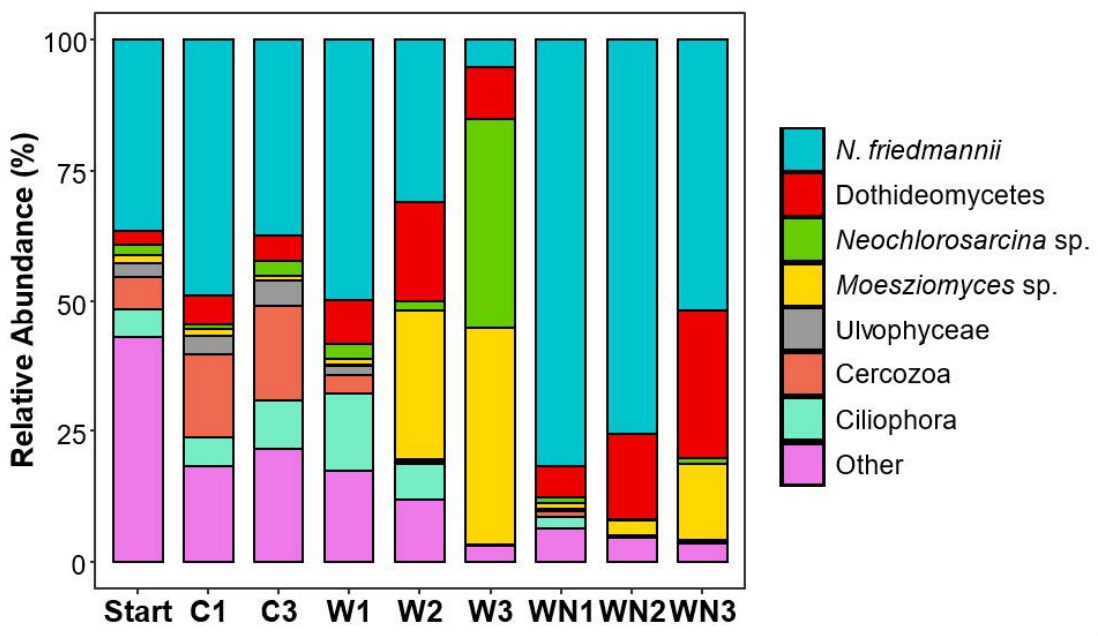
Figure 2. Taxonomy of the eukaryotic community shift in response to water ( + W) and water + nutrients ( + WN) amendments in the microcosm experiment. Stacked bar graphs showing relative abundances of dominant eukaryotic taxa (from 18S rRNA gene sequencing data). Taxonomy is from the Greengenes database. Bars represent means ( n = 4). Most of the “Other” category in the starting soil is plant material (Vimercati et al. 2016). A stacked bar graph of bacterial community shifts can be found in Figure S3. N. friedmannii , Neochlorosarcina sp., Moesziomyces sp. and Ulvophyceae are each represented by one OTU. Dothideomycetes are all in the Pleosporales